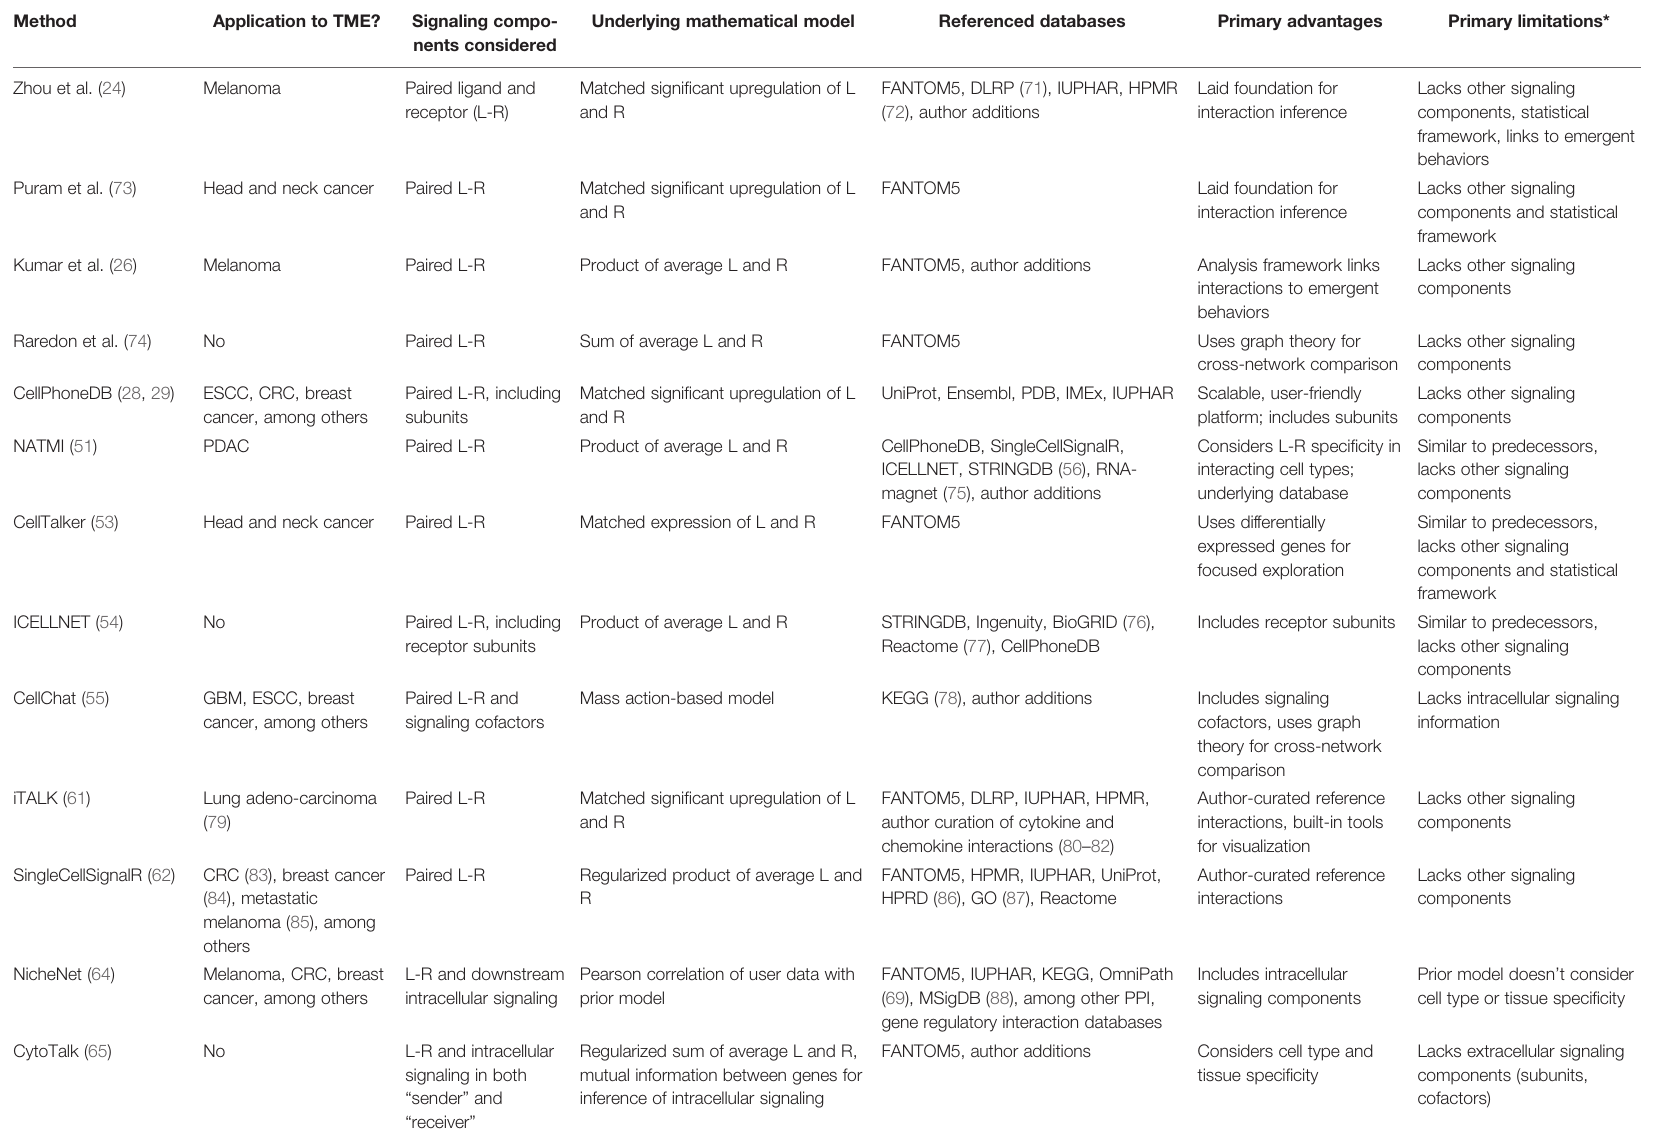
TABLE 2 | Selected summary of computational methods for inference of cell-cell